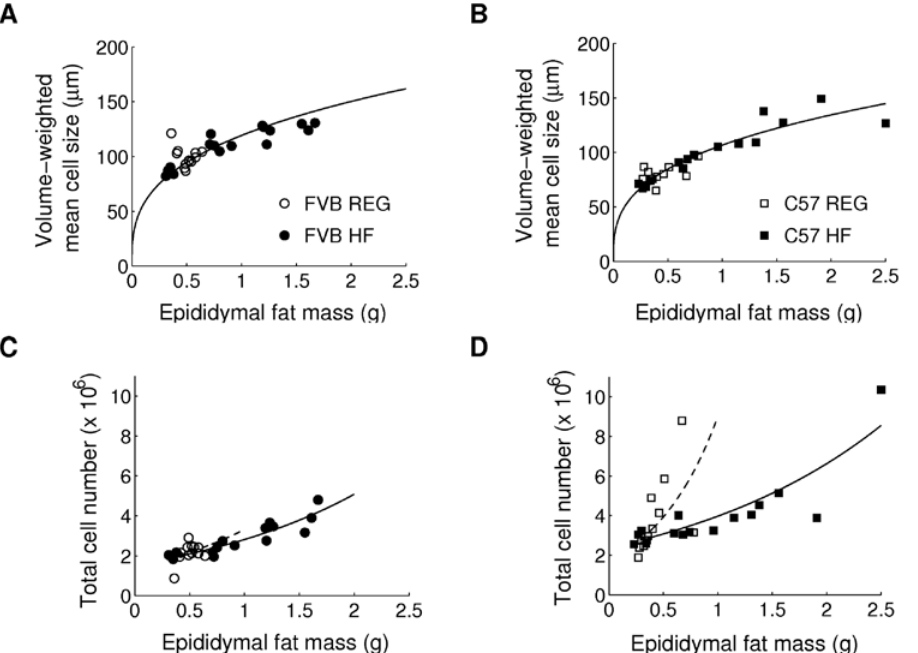
Figure 4. Size and number increase of epididymal fat cells with respect to epididymal fat pad mass. (A) and (B): the correlation between epididymal fat pad mass m and volume-weighted mean cell size j s is fitted with a power law j s ~ am 1 = 3 with (A) a ~ 119 and (B) a ~ 107 , which is plotted with solid lines. (C) and (D): the correlation between epididymal fat pad mass m and total cell number j n is fitted into an exponential function j n ~ N 0 e c m { m 0 ð Þ with initial fat pad mass m 0 , initial cell number N 0 , and cell-number increasing rate c , plotted with dashed lines (chow diet) and solid lines (high-fat diet). Fitted parameter values are summarized in Table 2.